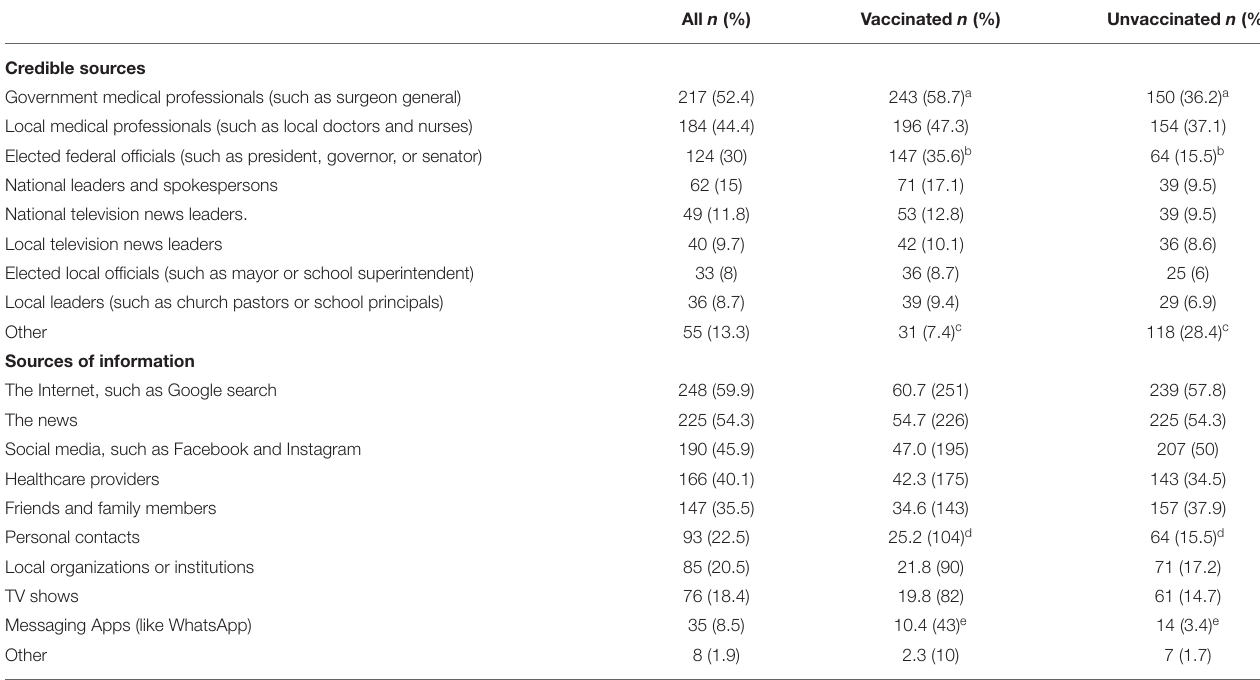
TABLE 3 | Cues-to-action (source and channel).